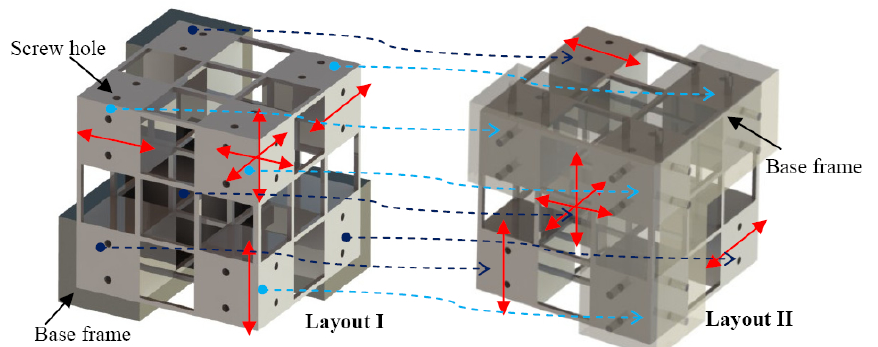
Figure 4. Demonstration of redundant design (rendered).